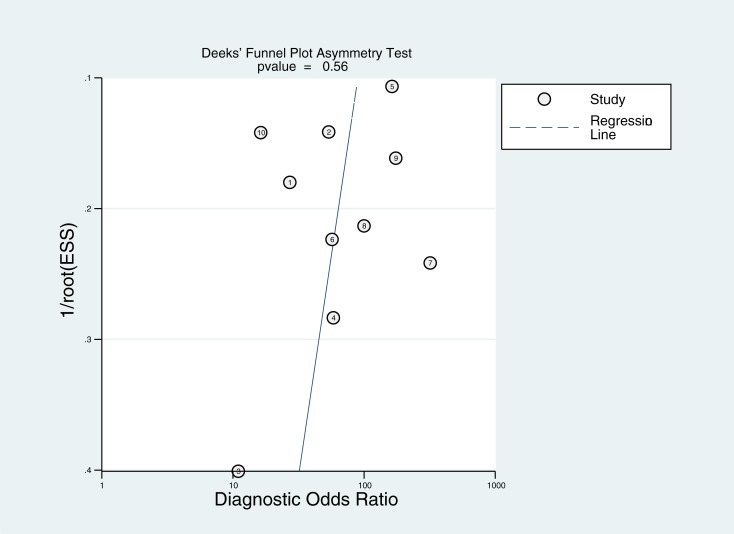
Deeks’ plot for ASVS for localization of insulinoma.